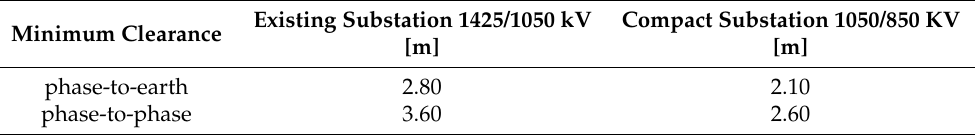
Table 1. Minimum air clearances and insulation levels (LIWV and SIWV) according to IEC